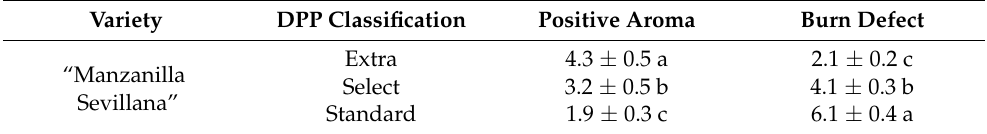
Table 2. Sensory aroma attributes of Californian-style black olives stuffed with hydrocolloids.